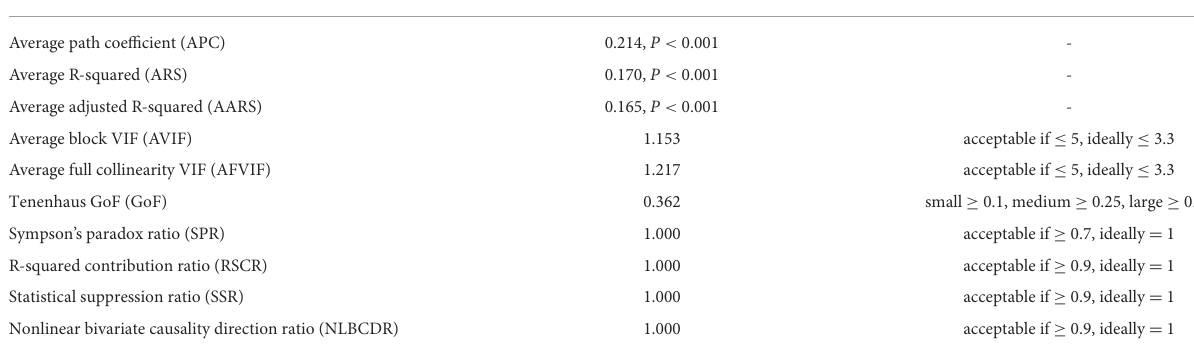
TABLE 4 Model fit and quality indices.